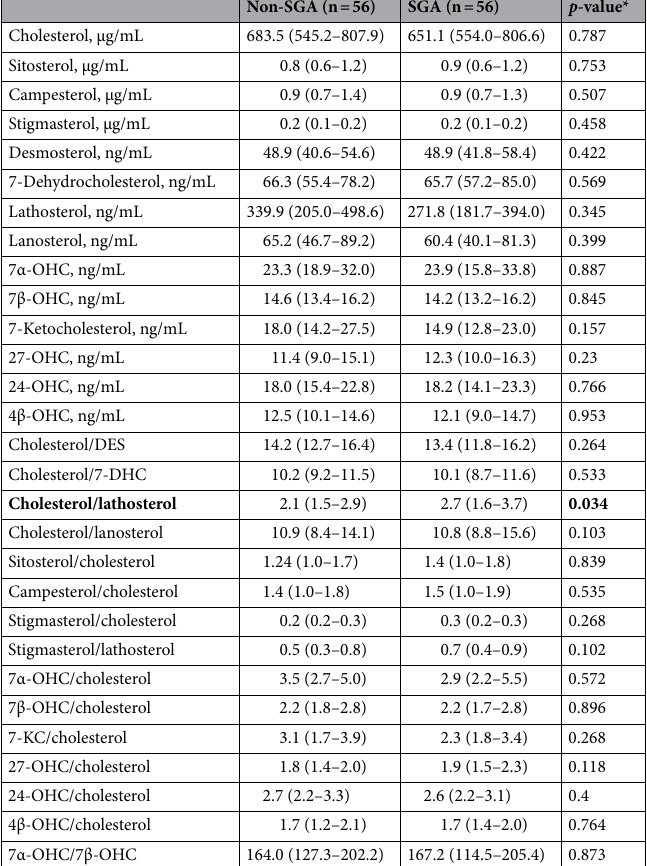
Table 4. Comparison of quantitative results of serum metabolic signatures of cholesterol between non-SGA and SGA groups. All values were presented by median (interquartile ranges). *Independent t -tests and Mann– Whitney U test where